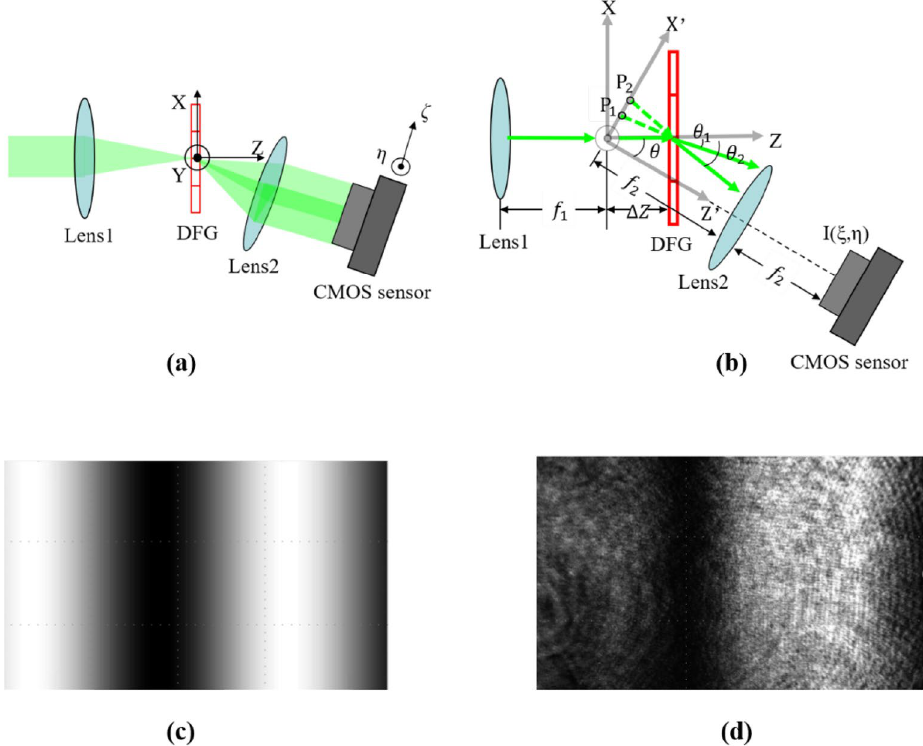
Figure 1. (a) The light path for the DFGSI, (b) the geometry, (c) the simulation of the interferogram by the two diffracted lights on the CMOS image sensor, and (d) the corresponding experimental